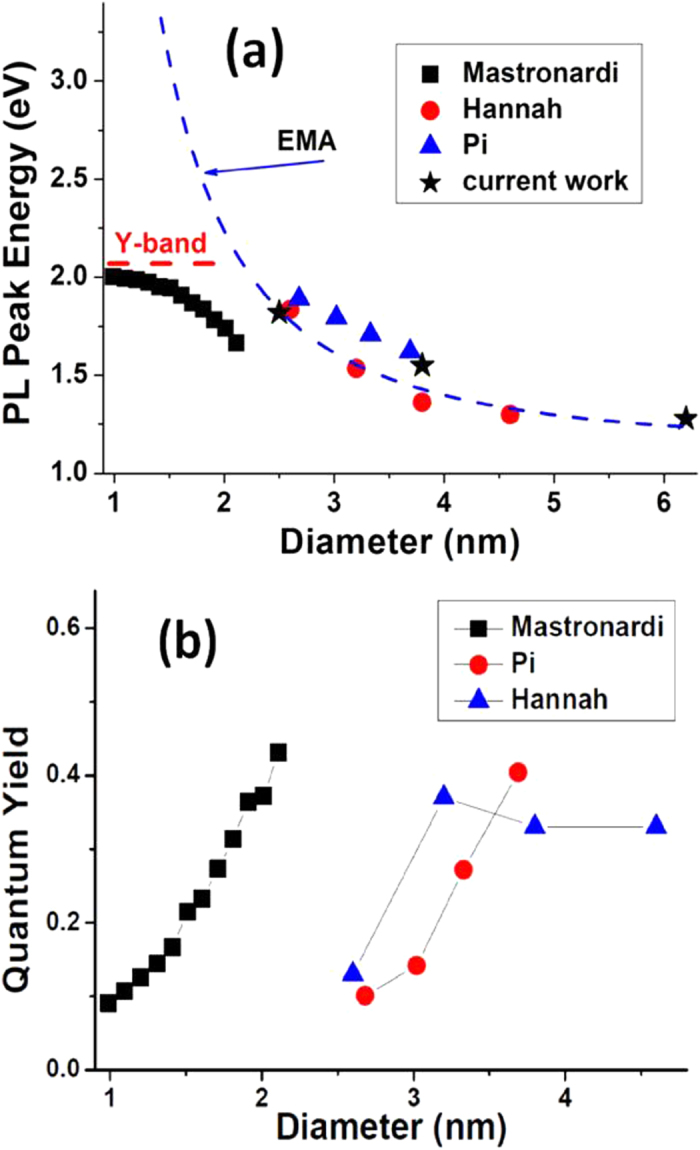
(a) Comparison for PL peak energy as a function of diameter of Si NCs from Mastronardi19, Hannah7, Pi12 and current work. The Y-band and the prediction Eg(r) = 1.12 + 4.57/r2 are indicated; (b) PL quantum yield as a function of diameters of Si NCs from Mastronardi19, Hannah7, and Pi12.